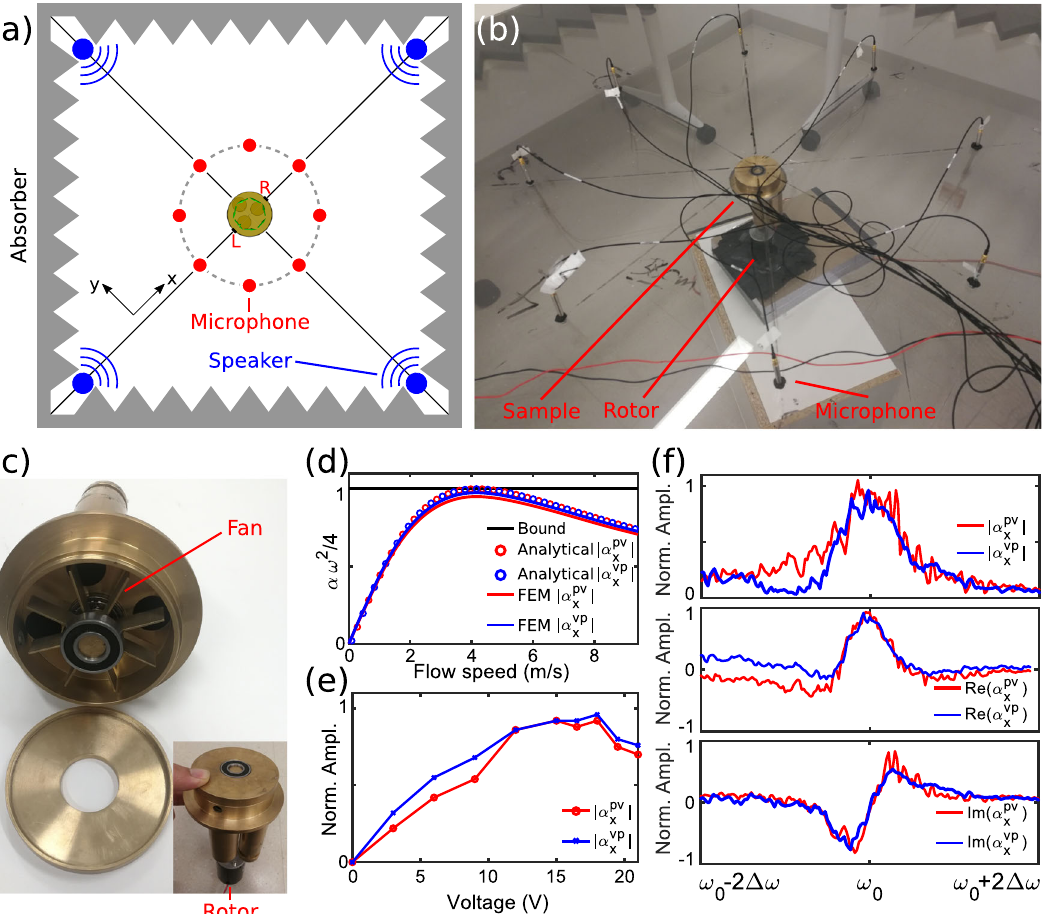
Fig. 2 Experimental measurement of odd Willis coupling. a , b Experimental set-up. c Fabricated sample. d Analytical and numerical calculations of the Willis coef fi cients as a function of rotational fl ow speed. e Measured Willis coef fi cients as a function of applied motor voltage. f Measured frequency dispersion of the Willis coef fi cients for a motor voltage of 16.5